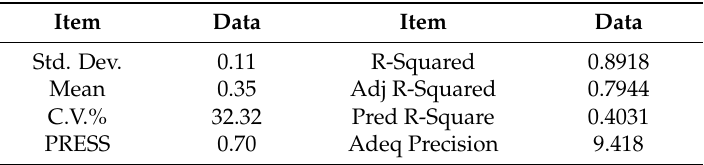
Table 4. The results of fitting second-order